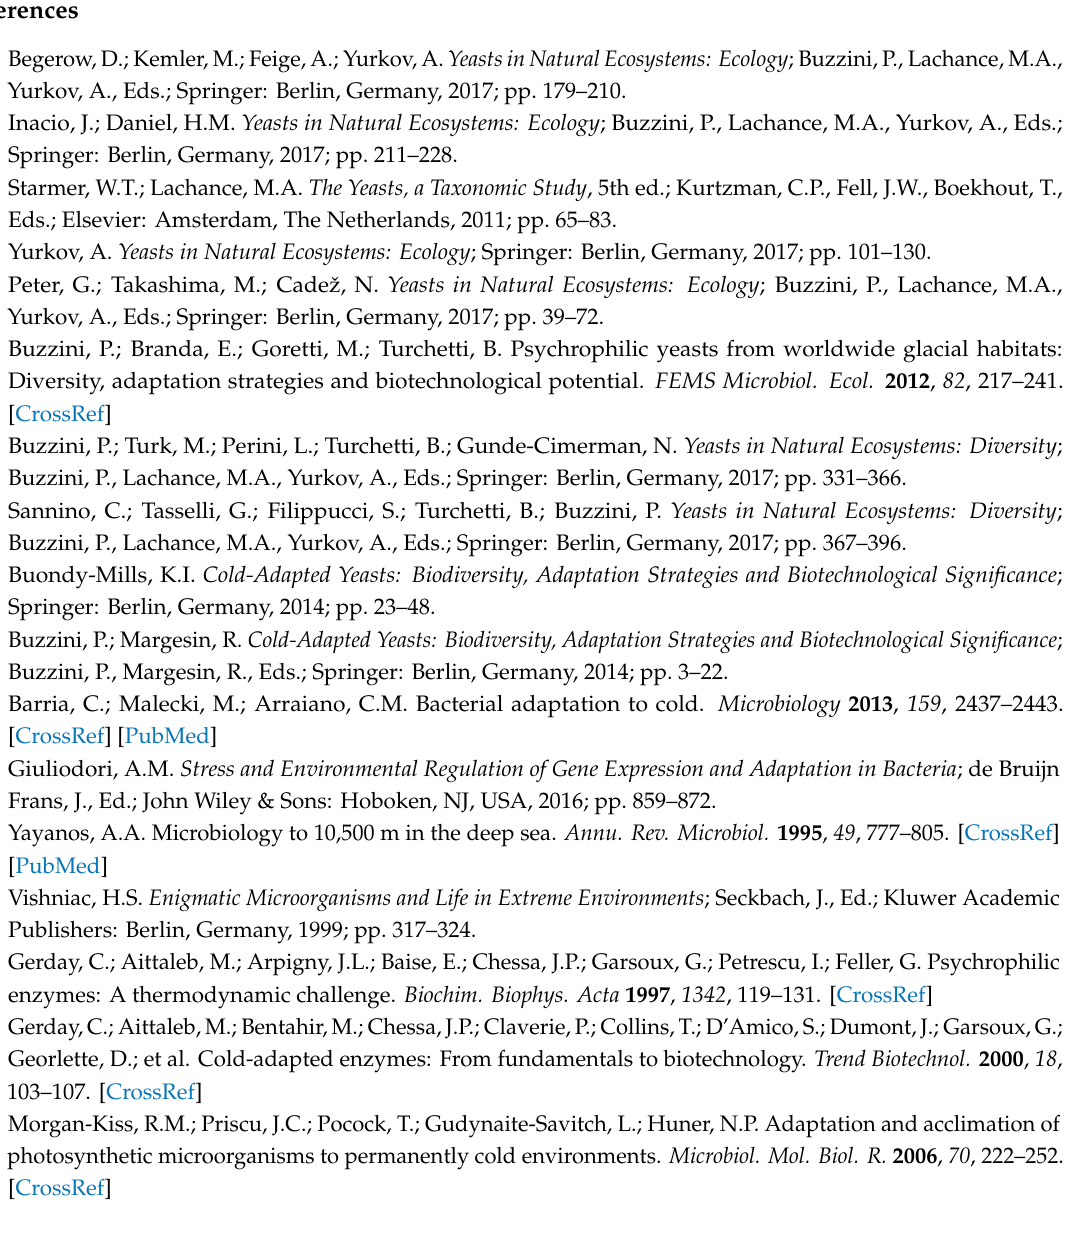
Table S1: Scoring dataset MSAP, Table S2: chi square control for the evaluation of the significance of the percentage of DNA methylation of N. antarctica DBVPG 5271 and N. albida DBVPG 10064 during the seeding and incubation cycles, Table S3: Methylation Sensitive Amplified Polymorphism (MSAP) primers